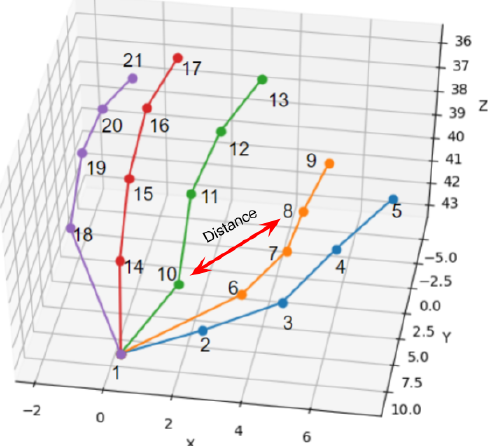
Figure 4. An example of distance-based features. Here, the distance between 8th and 10th joint points is being